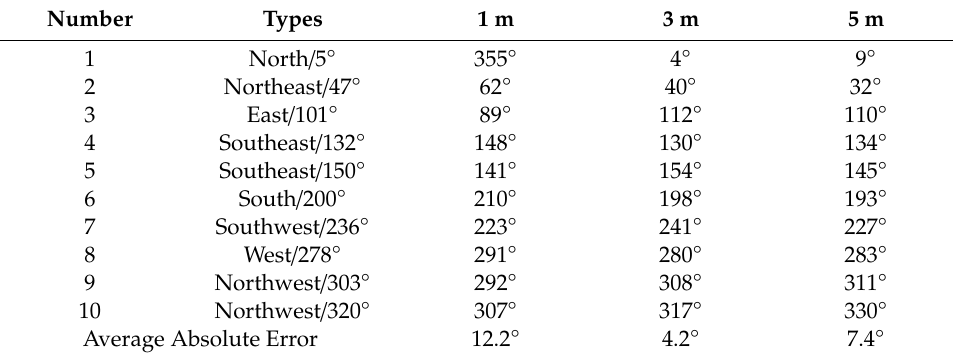
Table 7. Result of direction estimation (accuracy).